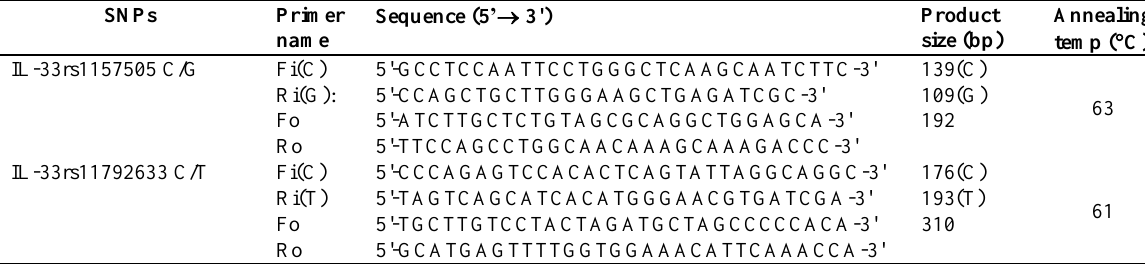
Table 2 . The sequences and annealing temperatures of the primers.